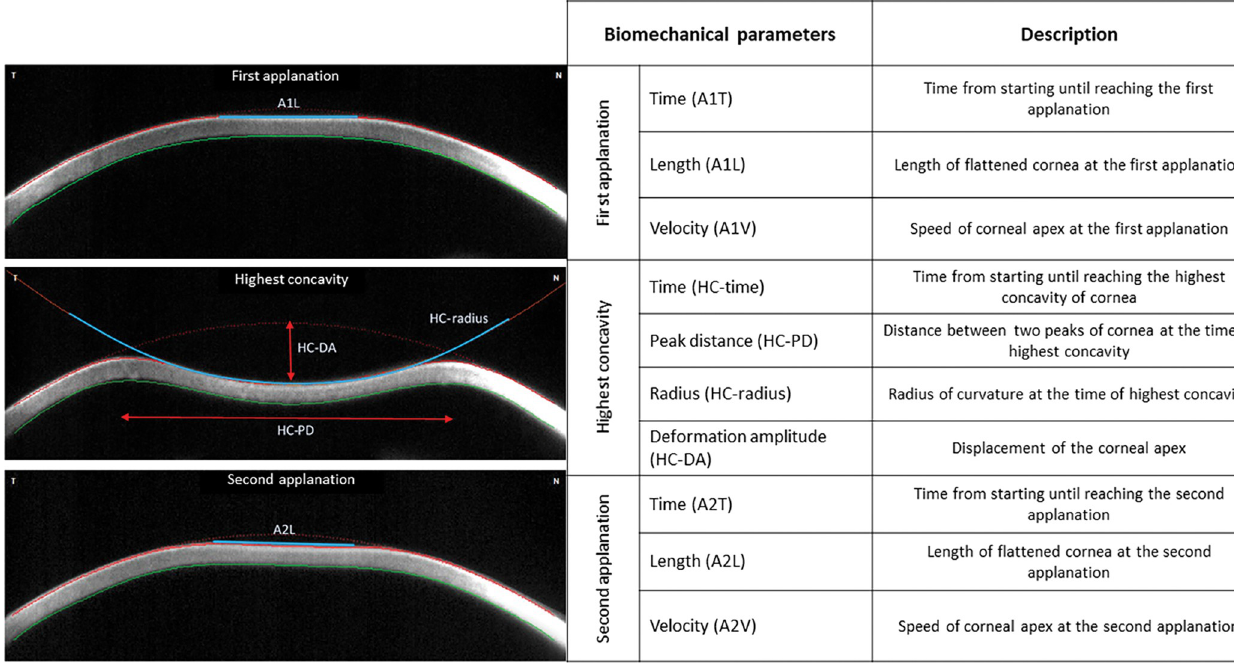
Fig 1. Corneal biomechanical parameters evaluated by Corvis ST.